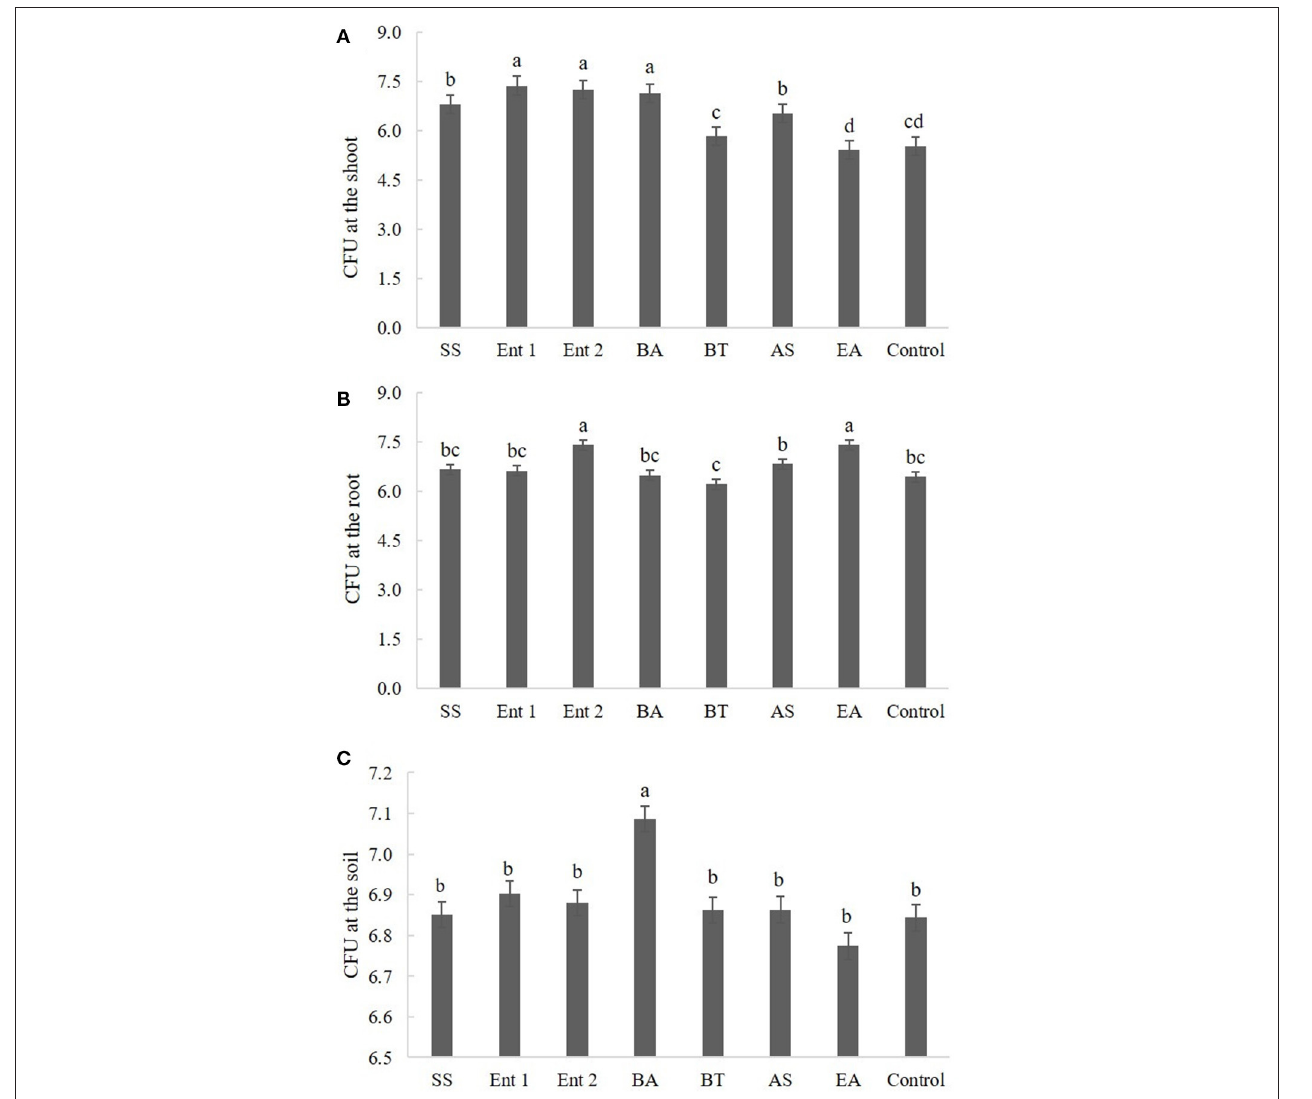
FIGURE 4 | Number of CFUs (A) endophytic in sugarcane shoots, (B) endophytic in sugarcane roots, and (C) on the soil. The data were transformed to log 10.